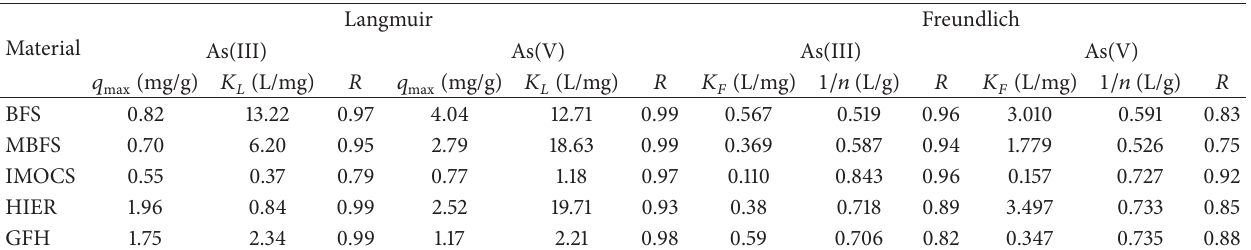
Table 3: Langmuir and Freundlich isotherm parameters for industrial by-products. Langmuir Material